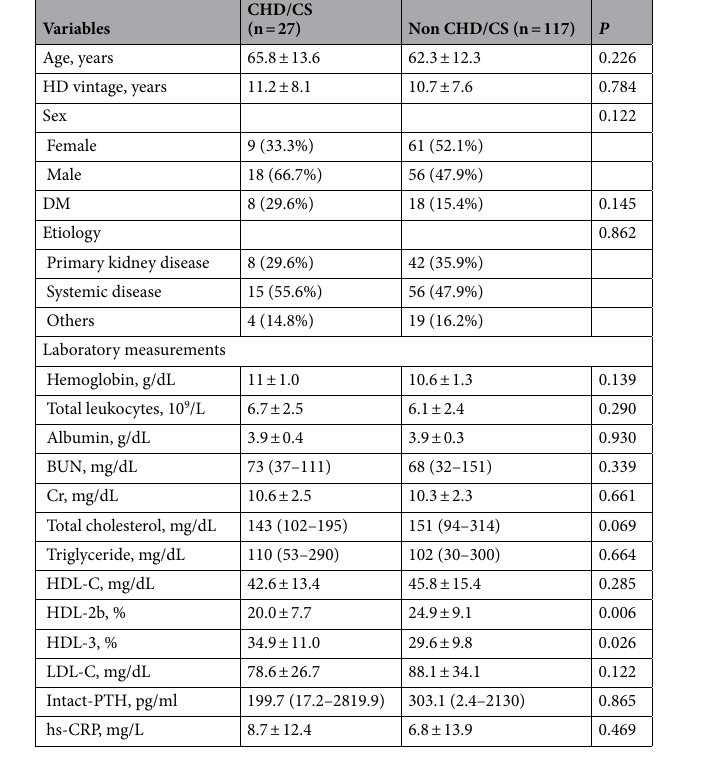
Table 2. Baseline characteristics in hemodialysis patients (N = 144). CHD coronary heart disease, CS cerebral